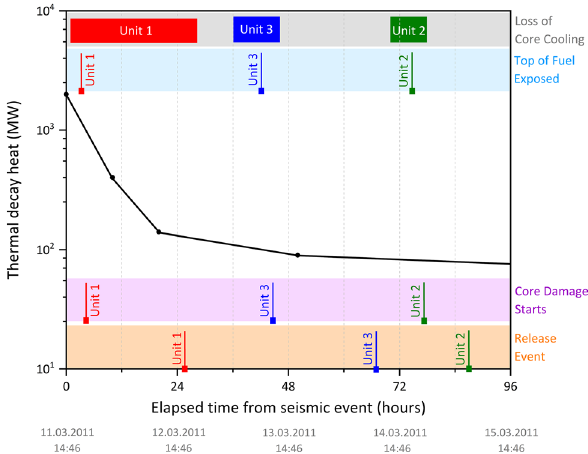
Figure 1. Modelled post-SCRAM reactor (thermal) decay heat associated with a typical FDNPP BWR Unit. The bars indicate periods over which appropriate core cooling capability was degraded; with the vertical